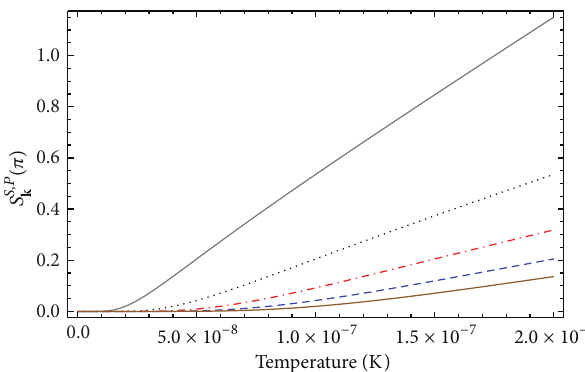
Figure 1: Plots of AAI for bosons, 𝑆 𝑆,𝑃 k as a function of temperature 𝑇 , for a time interval 𝑡 = 1 /𝜔 and for sample values of 𝜔 ∈ [ 2 × 10 4 s − 1 , 10 5 s − 1 ] , 𝜔 = 2 × 10 4 s − 1 (gray solid line), 𝜔 = 4 × 10 4 s − 1 (black dotted line), 𝜔 = 6 × 10 4 s − 1 (red dot dashed line), 𝜔 = 8 × 10 4 s − 1 (blue dashed line), and 𝜔 = 10 5 s − 1 (brown solid line).